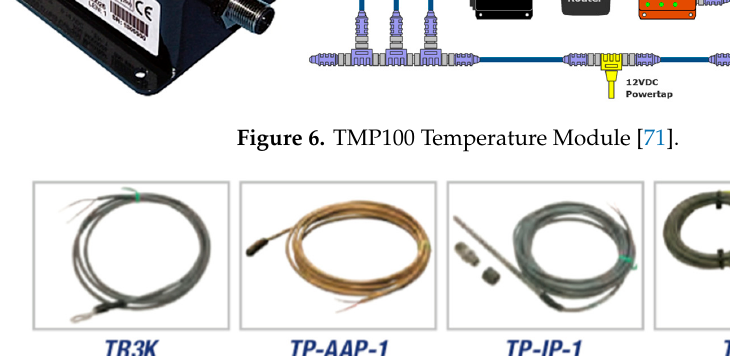
Figure 7. Temperature probes to be used with TMP100 temperature module [71].